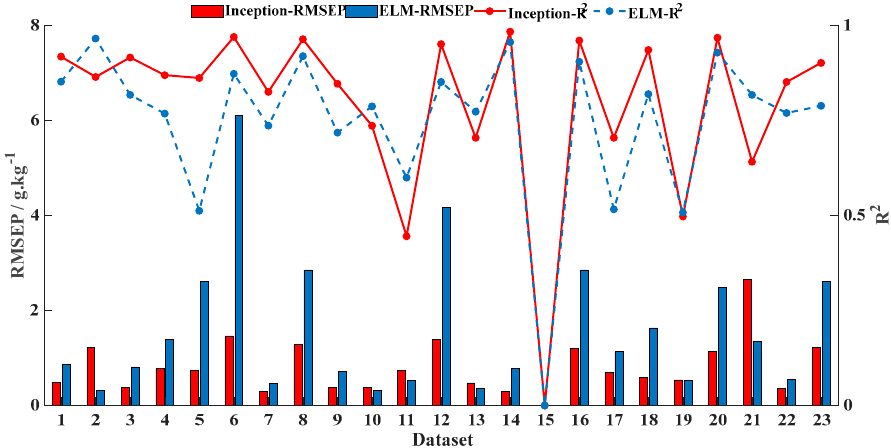
Figure 9. Effects of predicted with CNN and ELM. Figure 9. E ff ects of predicted with CNN and